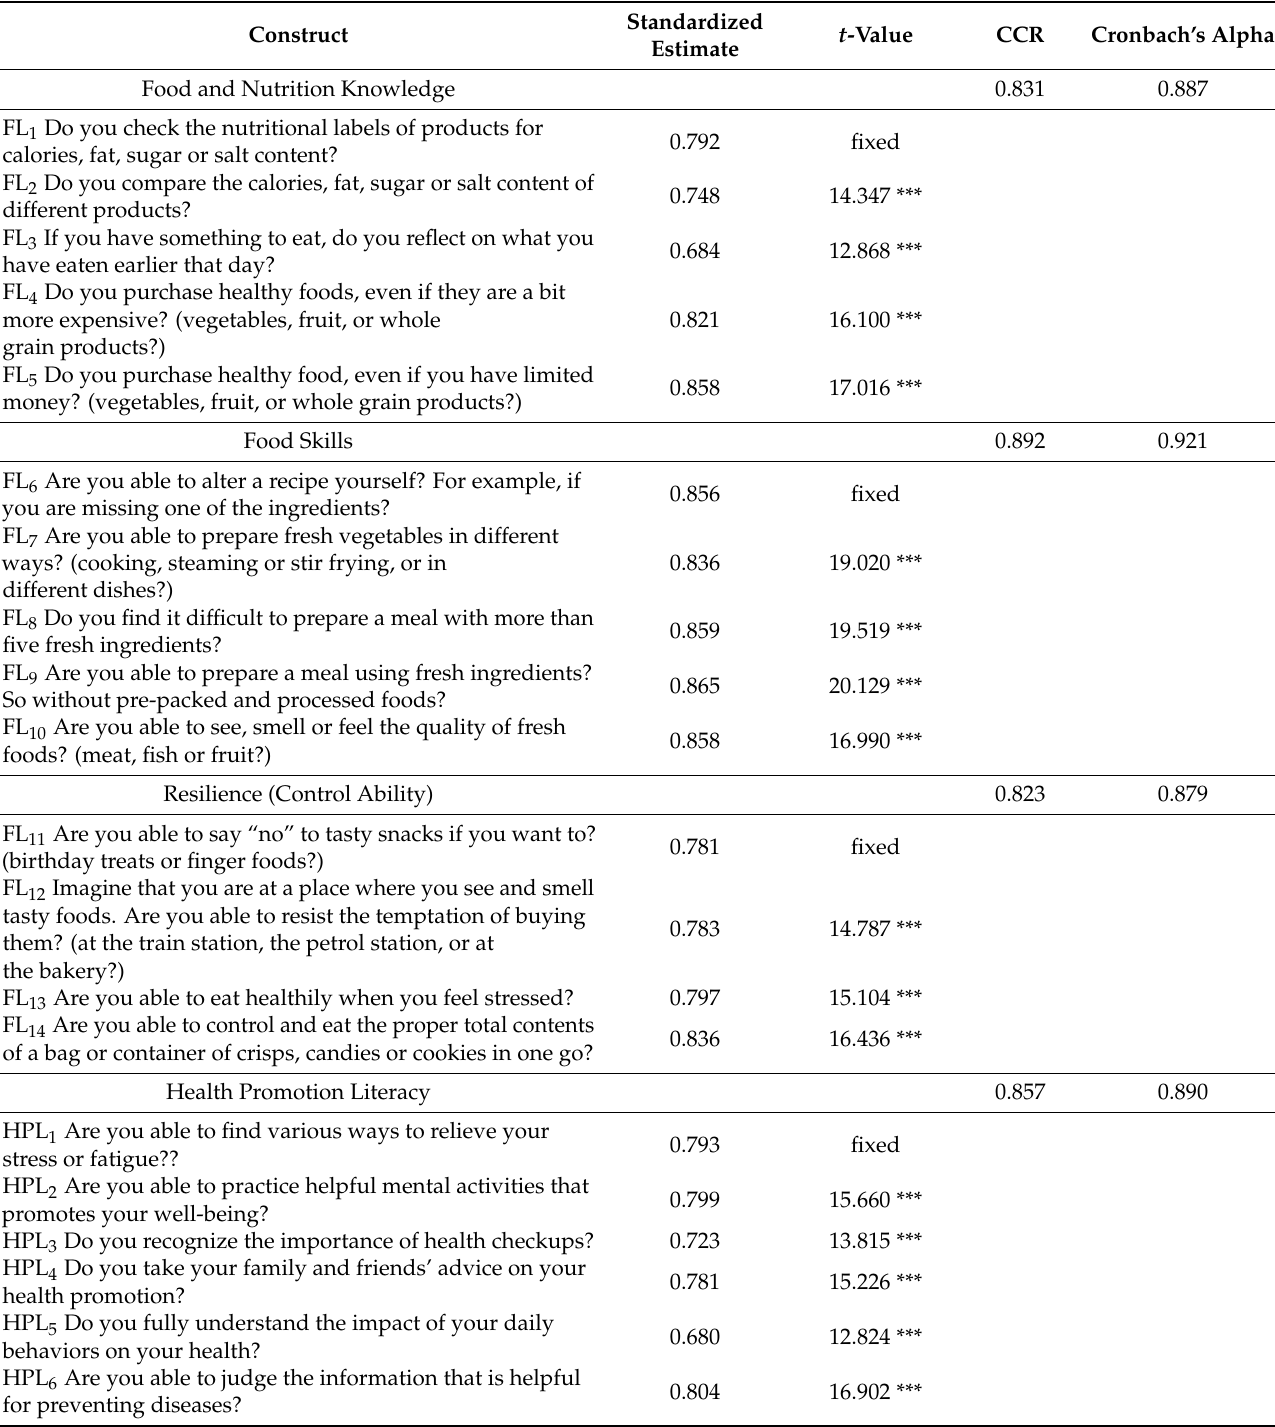
Table 1. Confirmatory factor analysis and reliability